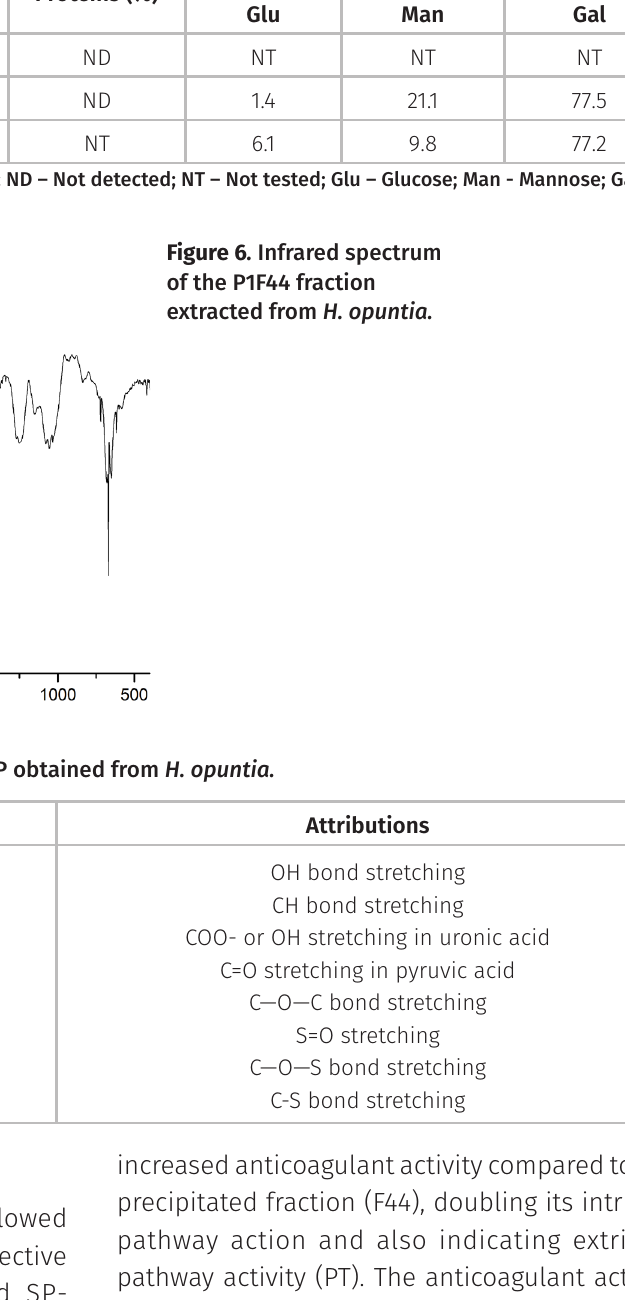
Table III. Chemical characterization of SP from obtained from H.opuntia. Fraction